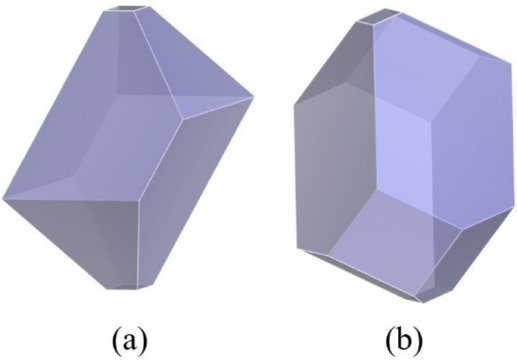
Figure 9. Simulation of β -HMX crystal morphology in PAA–DMSO and PEI–DMSO systems with the mass fraction of 10% at 298 K. ( a ) PAA-induced, ( b )